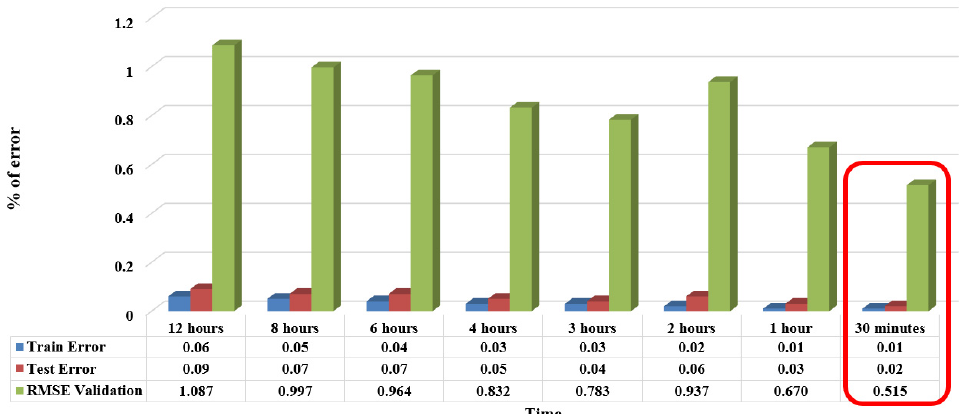
Figure 7. Comparison error results of the Soil Moisture value forecasting in different time intervals (Bi-LSTM model).